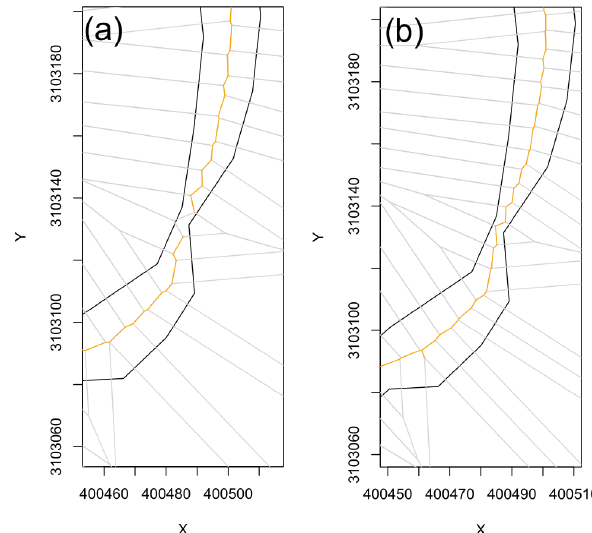
Figure 7. (a) A gap in the centerline occurs when the spacing of the bank points is too large compared to the channel width; (b) the gap fixed by increasing the resolution of the bank points through the parameter